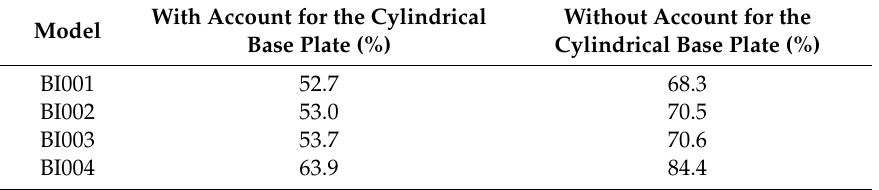
Table 3. Porosity of the models with and without account for the cylindrical base plate (%).